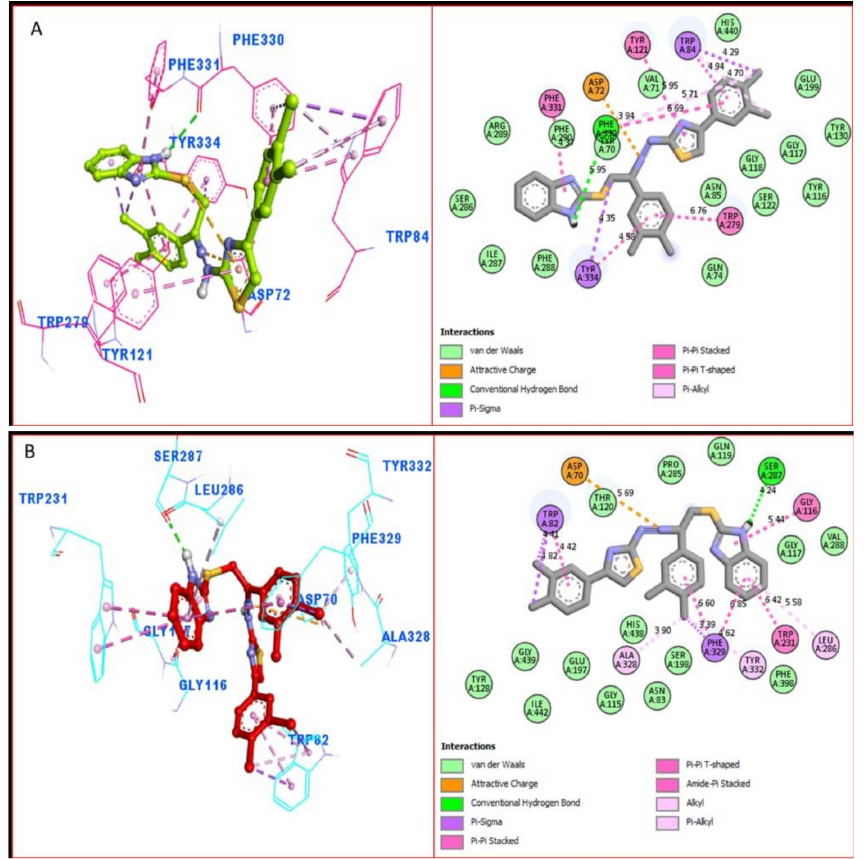
Figure 10. The PLI profile of the most potent analogue ( 21 ): ( A ) analogue 21 against acetyl- cholinesterase (AChE); ( B ) analogue 21 against butyrylcholinesterase (BuChE)